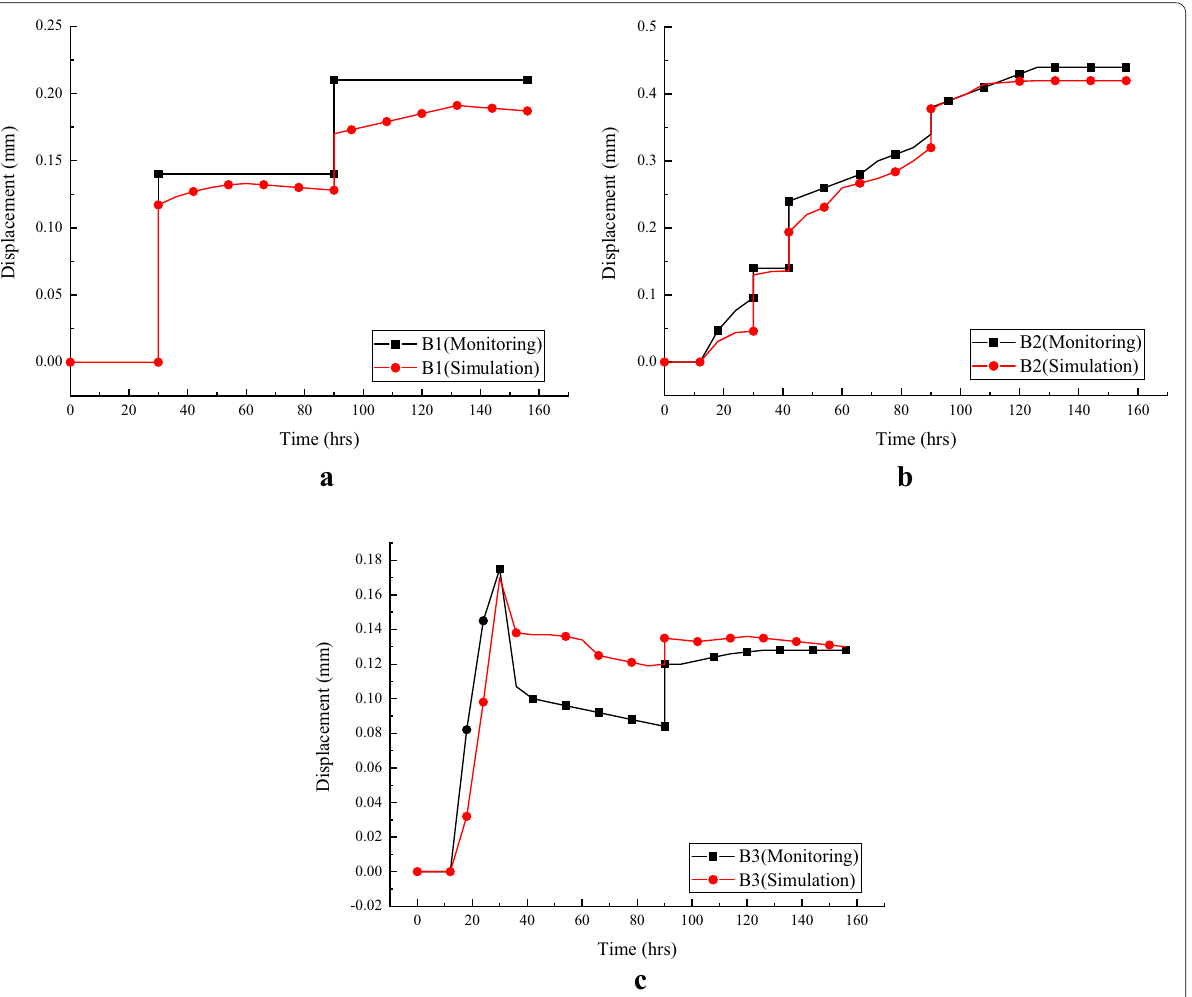
Fig. 15 Comparison of the barricade displacement evolution versus time between simulation and measurement corresponding to the sensors of B1 ( a ), B2 ( b ) and B3 ( c